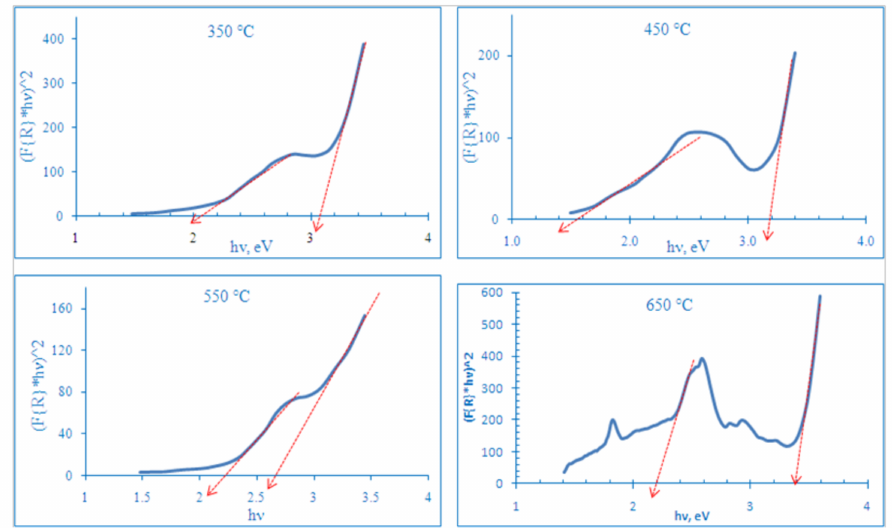
Figure 7. Kubelka-Munk transferred diffuse reflectance spectra of samples annealed at 350, 450, 550 and 650 ◦ C. The intersections of red rows with X-axis represent the values of band gap energy.